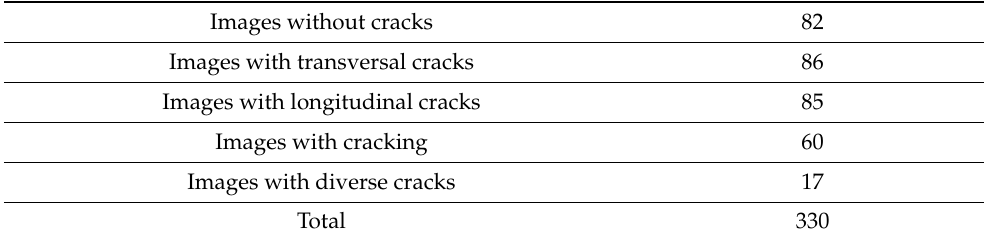
Figure 17. Examples of images from our dataset obtained in static mode. Table 2. Dataset